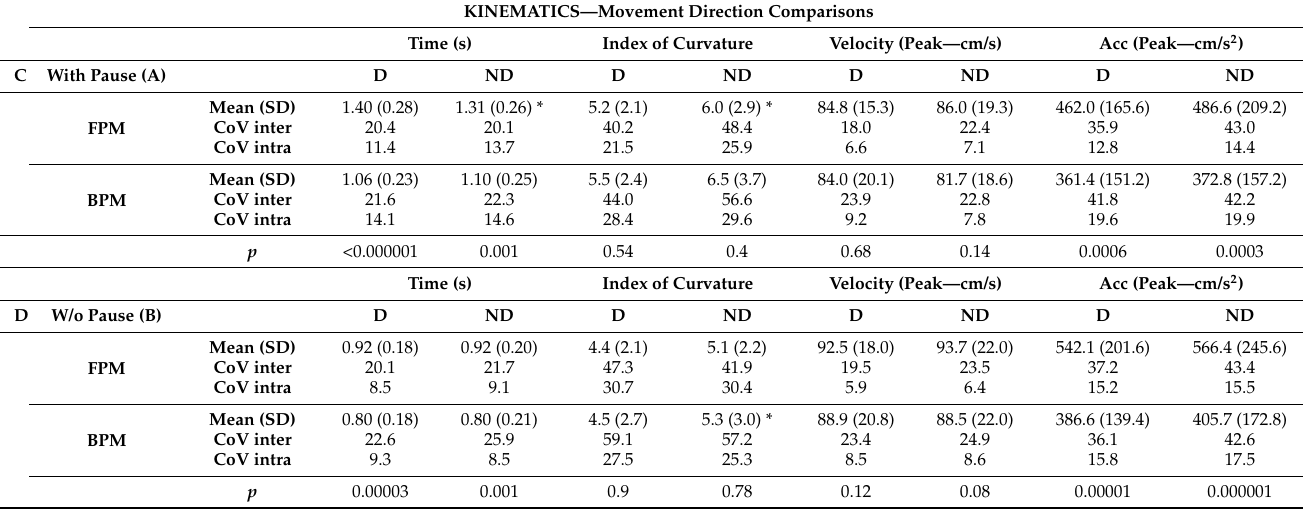
Table 2. Movement direction comparisons across sets.